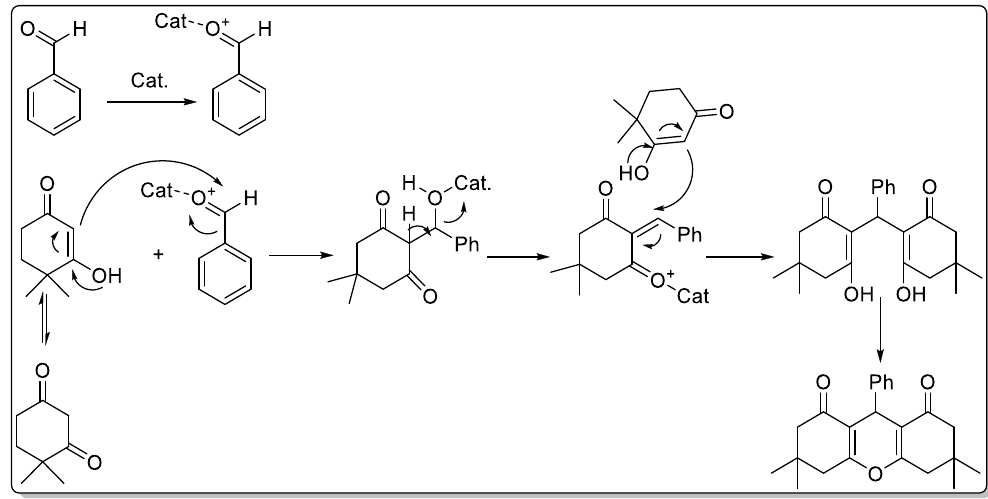
Figure 7. Plausible reaction mechanism for the synthesis of xanthenes.